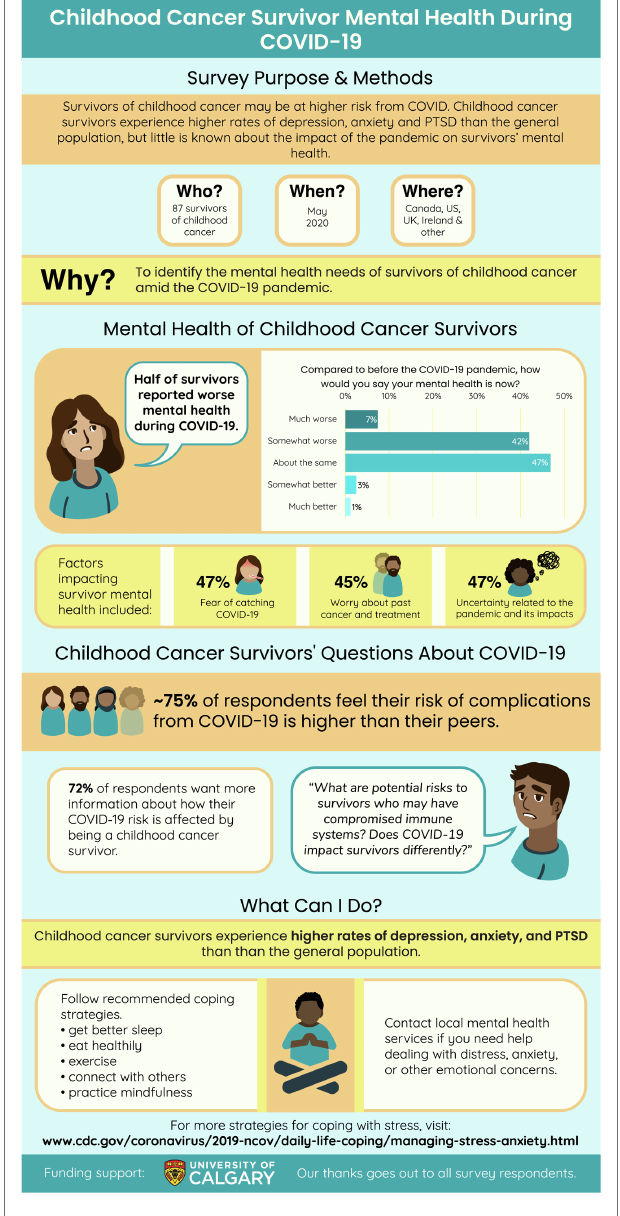
FIGURE 2 | Infographic for AYA survivors of childhood cancer on coping with